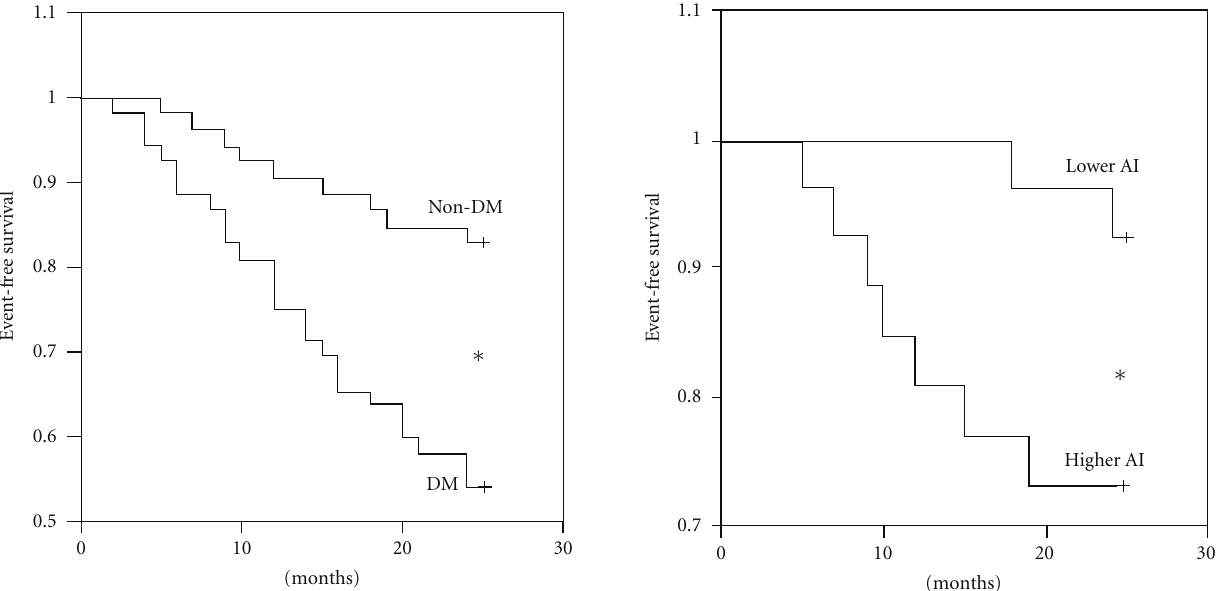
Figure 4: Kaplan-Meier analysis on nondiabetic hemodialysis patients showed that those with higher AI failed to live cardiovas- cular event-free lives similar to those with the lower AI. Log-rank test denoted that there was a significant di ff erence in cardiovascular events between two